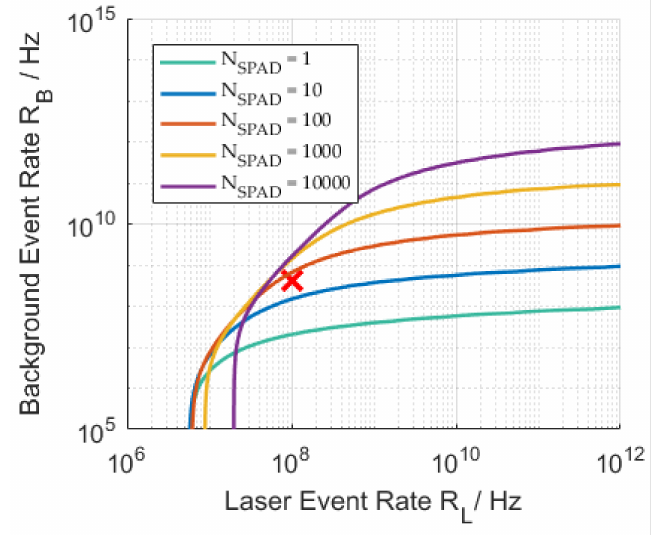
Figure 6. SNR = 3 contours of the multi pixel SPAD detector with η PDE = 0.2, k = 1 for different pixel numbers N SPAD = [ 1, 10, 100, 1000, 10,000 ] plotted over total event rates R B and R L . Other values from Table 1. Red cross: Multi pixel scenario used in Figure 7.